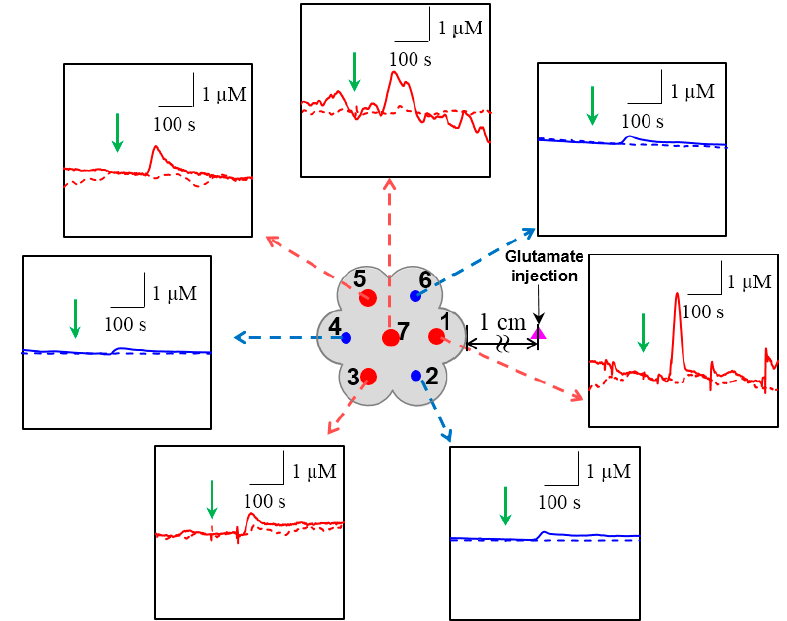
Figure 4. The concentration changes of NO (blue, locations 2, 4, 6) and CO (red, locations 1, 3, 5, 7) responding to 50 nM glutamate administration (marked with green arrows), measured with a septuple NO/CO sensor for differentiated cells (solid lines) and in only medium without cells (dashed lines). The glutamate injection site is marked with a pink triangle.